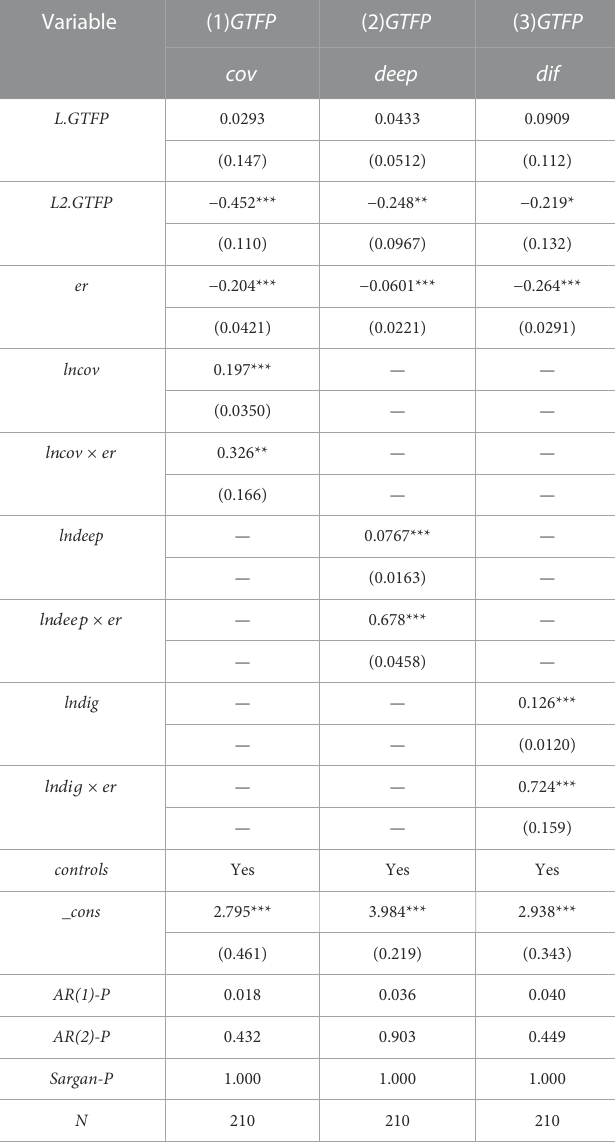
TABLE 3 Sub-dimensional regression